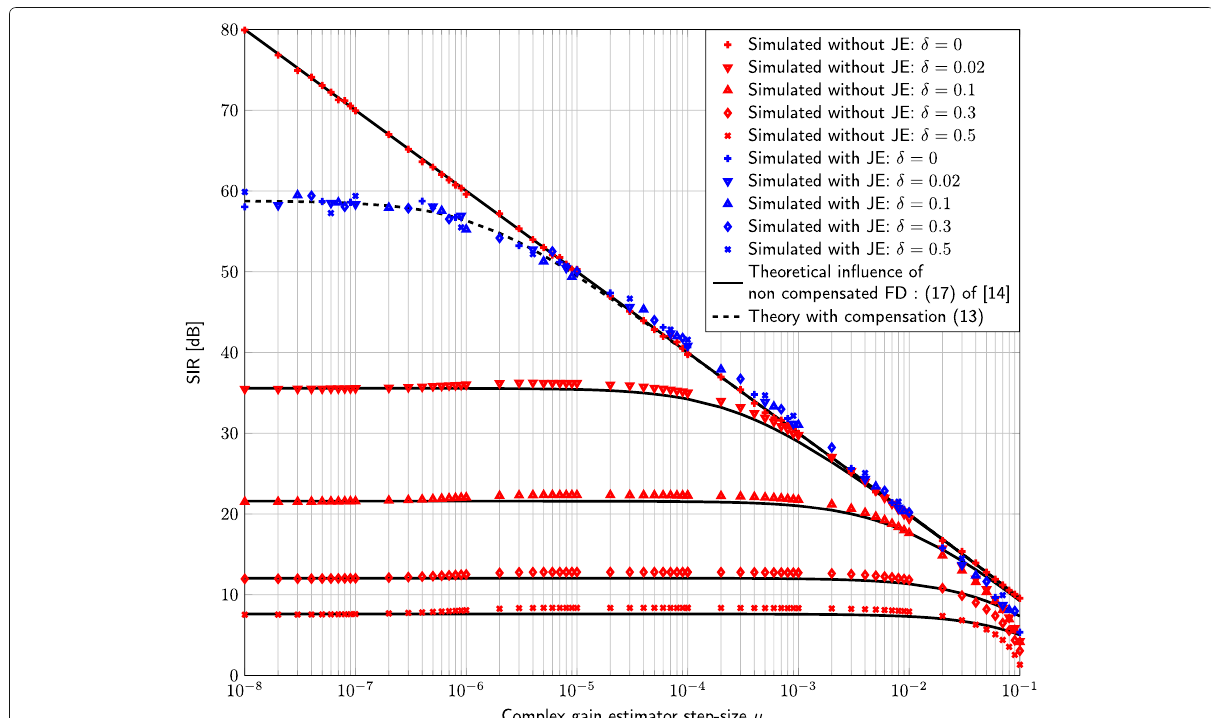
Fig. 7 JE asymptotic performance. Asymptotic performance of the compensation algorithm for several values of the complex gain step-size and for different values of fractional delays for a fixed fractional delay step-size ν = 10 − 6 /σ 2